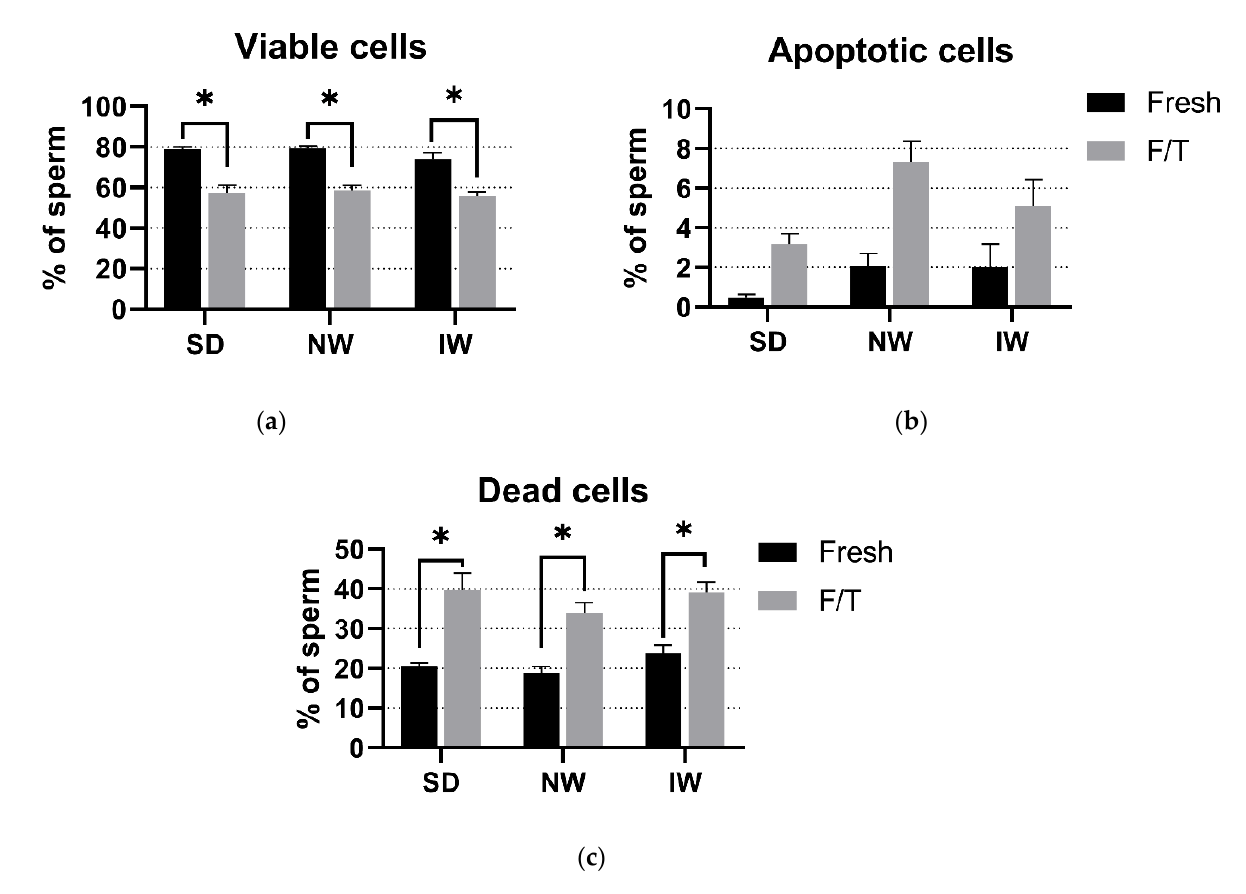
Figure 4. Comparative analysis of viable ( a ), apoptotic ( b ), and dead ( c ) spermatozoa among the breeds. SD — Slovak Dairy, NW — Native Wallachian, and IW — Improved Wallachian. No significant differences ( p > 0.05) among breeds were found. * Significant difference ( p < 0.05) between the fresh and F/T groups in the number of viable and dead sperm. The data are represented as means ± SEM.